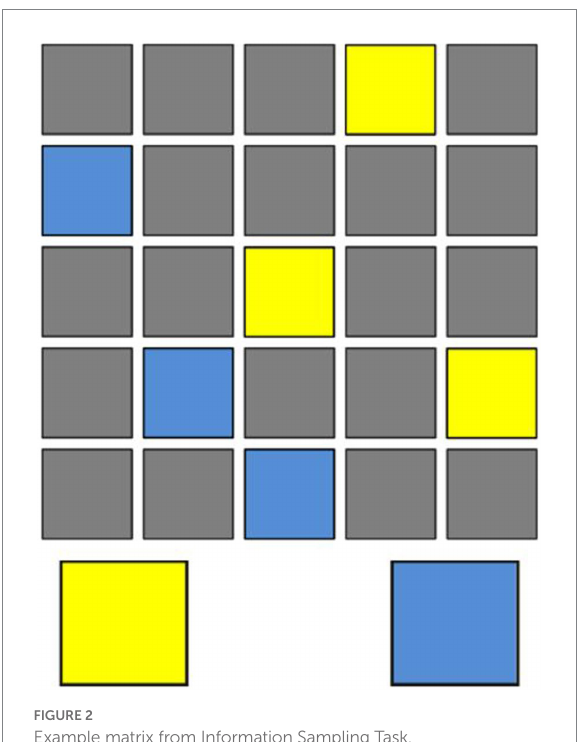
FIGURE 2 Example matrix from Information Sampling